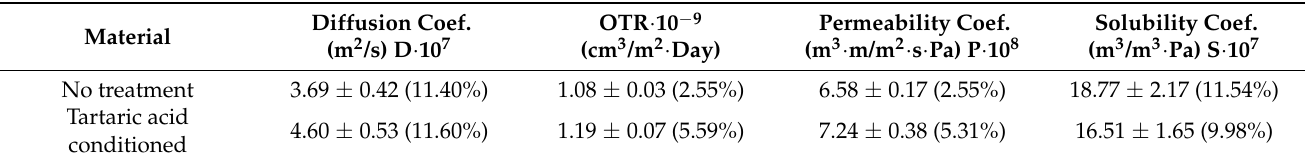
Figure 10. Detail of the variation in the composition of the material and highlights of the pieces of metal (orange) and the air holes (red) that will undoubtedly affect the permeability performance of the concrete block. Table 8. Main permeation results of tested samples extracted from concrete blocks supplied by Bodegas Ram ó n Bilbao (C-RB) ( n = 8) in time lag